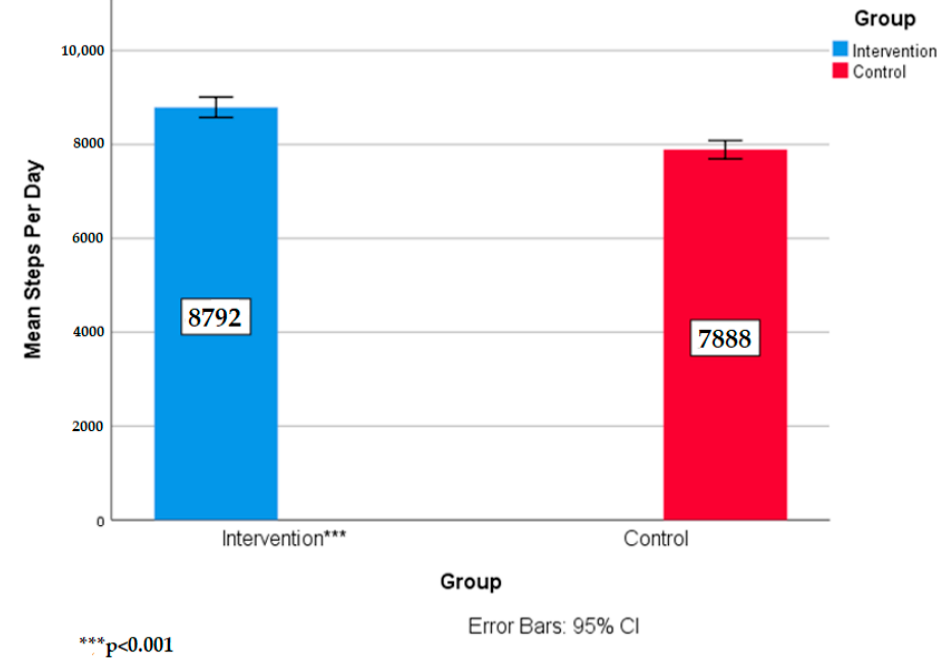
Figure 1. Means and standard deviations of steps per day by